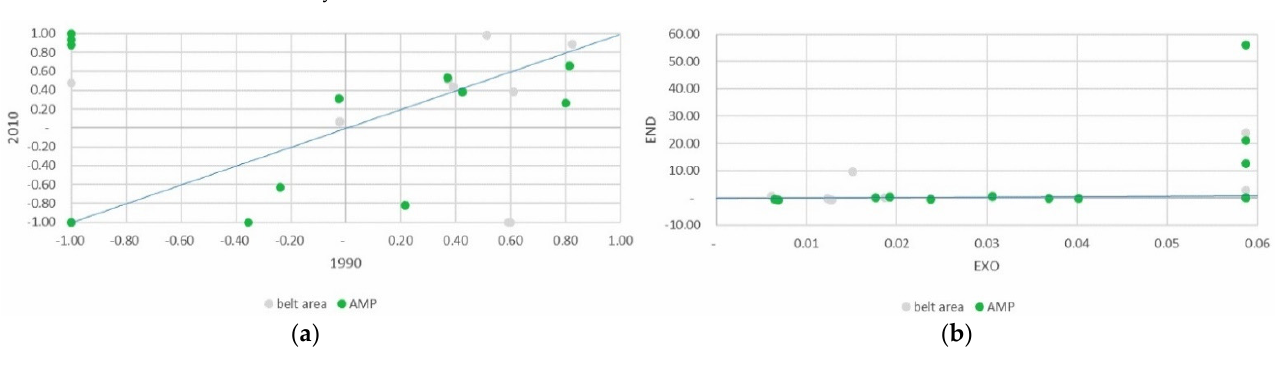
by the ISTAT. by the